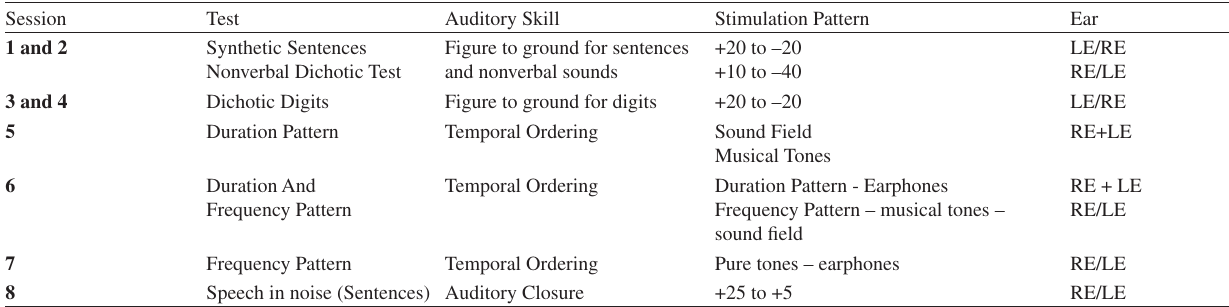
Table 1 - Formal Auditory Training (FAT) Schedule Session